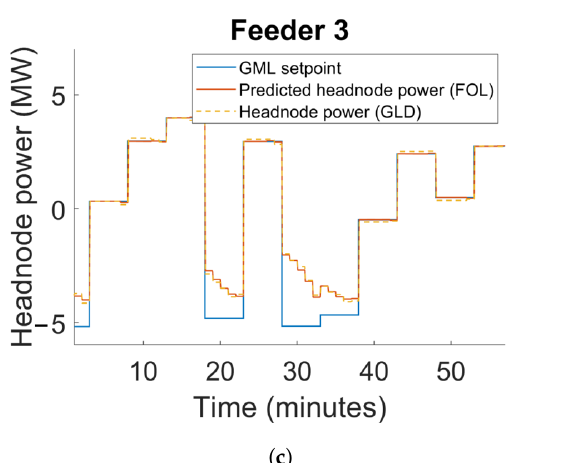
Figure 17. GML setpoint tracking performance for the fully modelled feeders in the FOL. ( a ) Feeder 1.